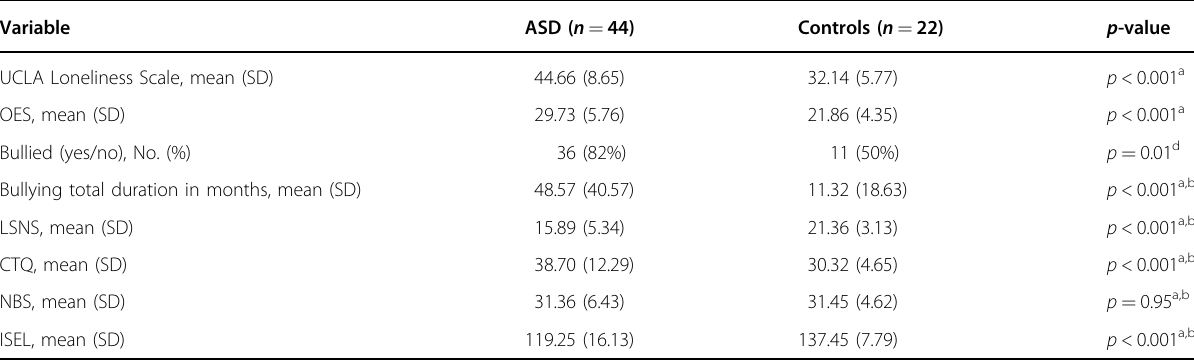
Table 2 Measures of social defeat in adults with autism spectrum disorder (ASD) and